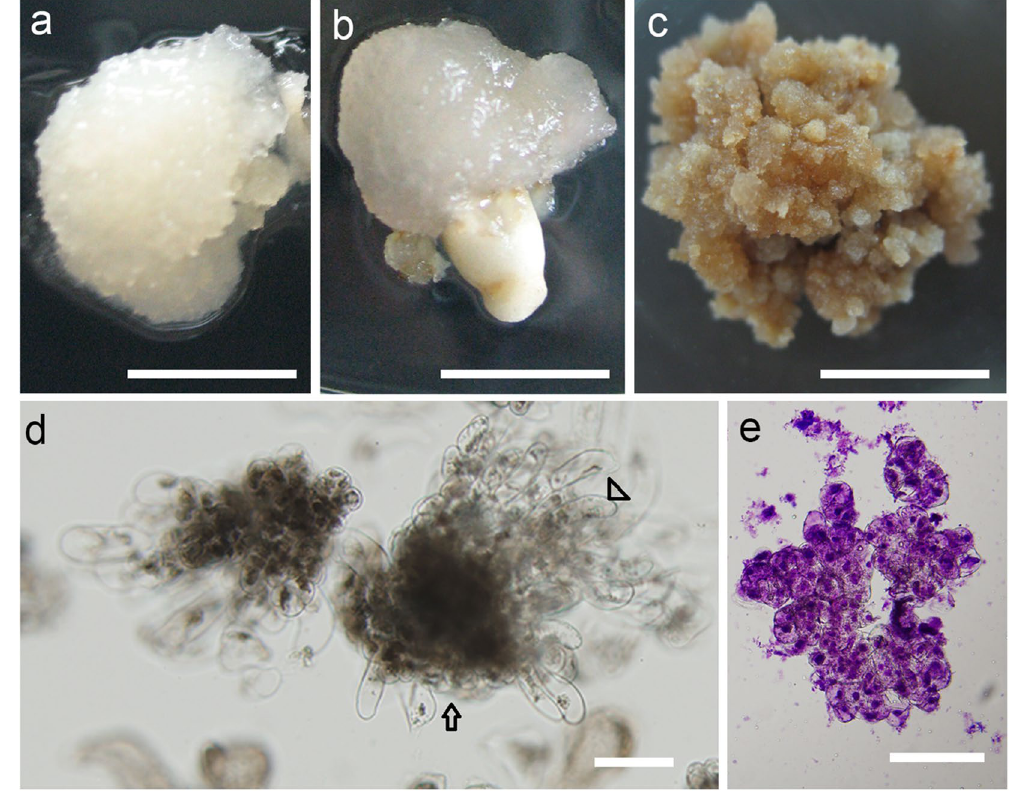
Figure 2. Morphological aspects of Cunninghamia lanceolate embryogenic cultures. ( a ) Embryogenic callus formed from an immature embryo. ( b ) Embryogenic callus formed from a megagametophyte. ( c ) Non- embryogenic callus. ( d ) Polarized embryogenic suspensor masses. Arrow shows embryogenic cells. Arrowhead shows suspensor cells. ( e ) Non-embryogenic callus cells stained with fuchsine. ( a–c ) Bars 5 mm, ( d , e ) bars 100 μ